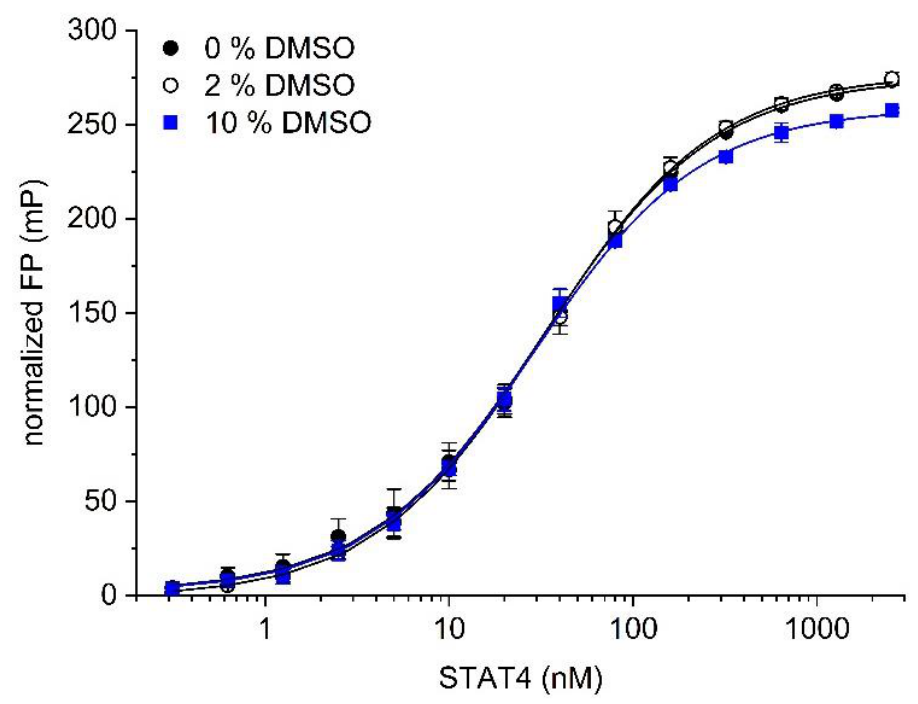
Figure 2. The effect of DMSO on binding of the probe 5-CF-GpYLPQNID to STAT4. Temporal stability is an important feature of a robust assay. Binding between 5-CF- GpYLPQNID and STAT4 was stable with respect to time, with only a minor loss of binding being observed up to 4 h after addition of the labelled probe, and no more than 35% reduction in affinity by 8 h (K d value 15 min: 33 ± 3 nM; 1 h: 34 ± 4 nM; 2 h: 35 ± 5 nM; 3